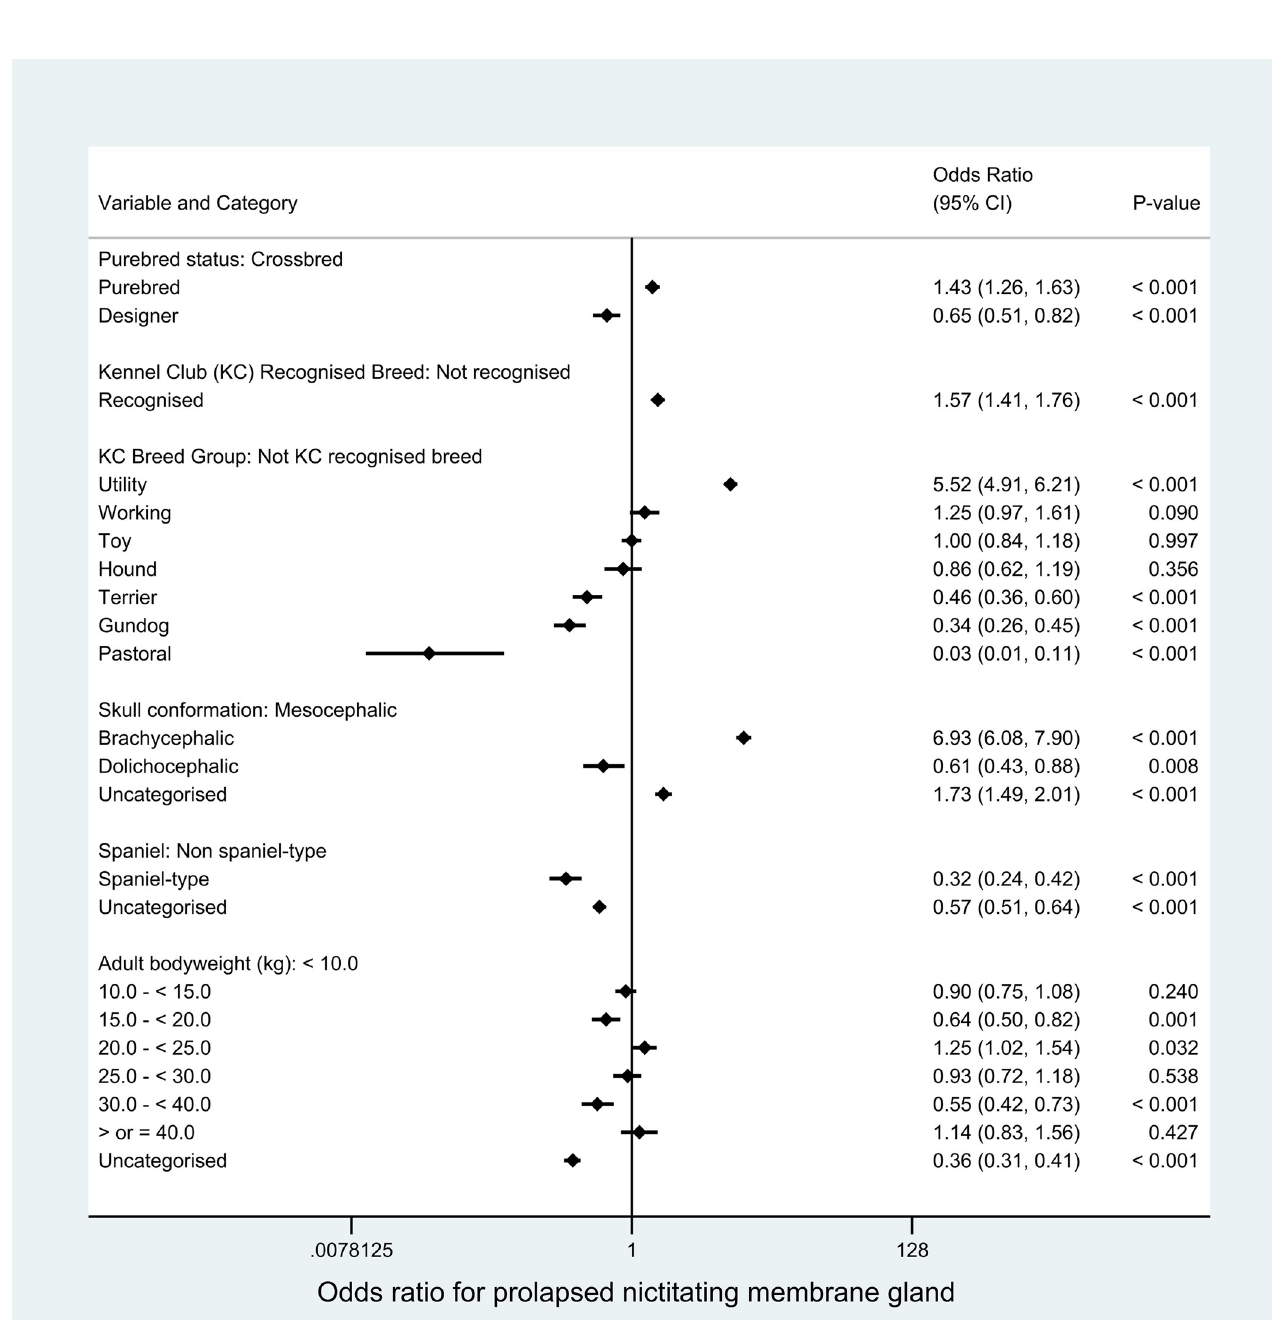
Fig 3. Results for risk factors that directly replaced the breed variable in the final breed-focused mixed effects multivariable logistic regression model (along with age, sex/neuter and insurance status). Adult ( > 18 months) bodyweight (kg) replaced the breed and bodyweight relative to breed mean variables in the final breed-focused mixed effects multivariable logistic regression model. These results report associations between these risk factors and prolapsed nictitating membrane gland (PNMG) in dogs under primary veterinary care in the VetCompass ™ Programme in the UK. Clinic attended was included as a random effect. � CI confidence